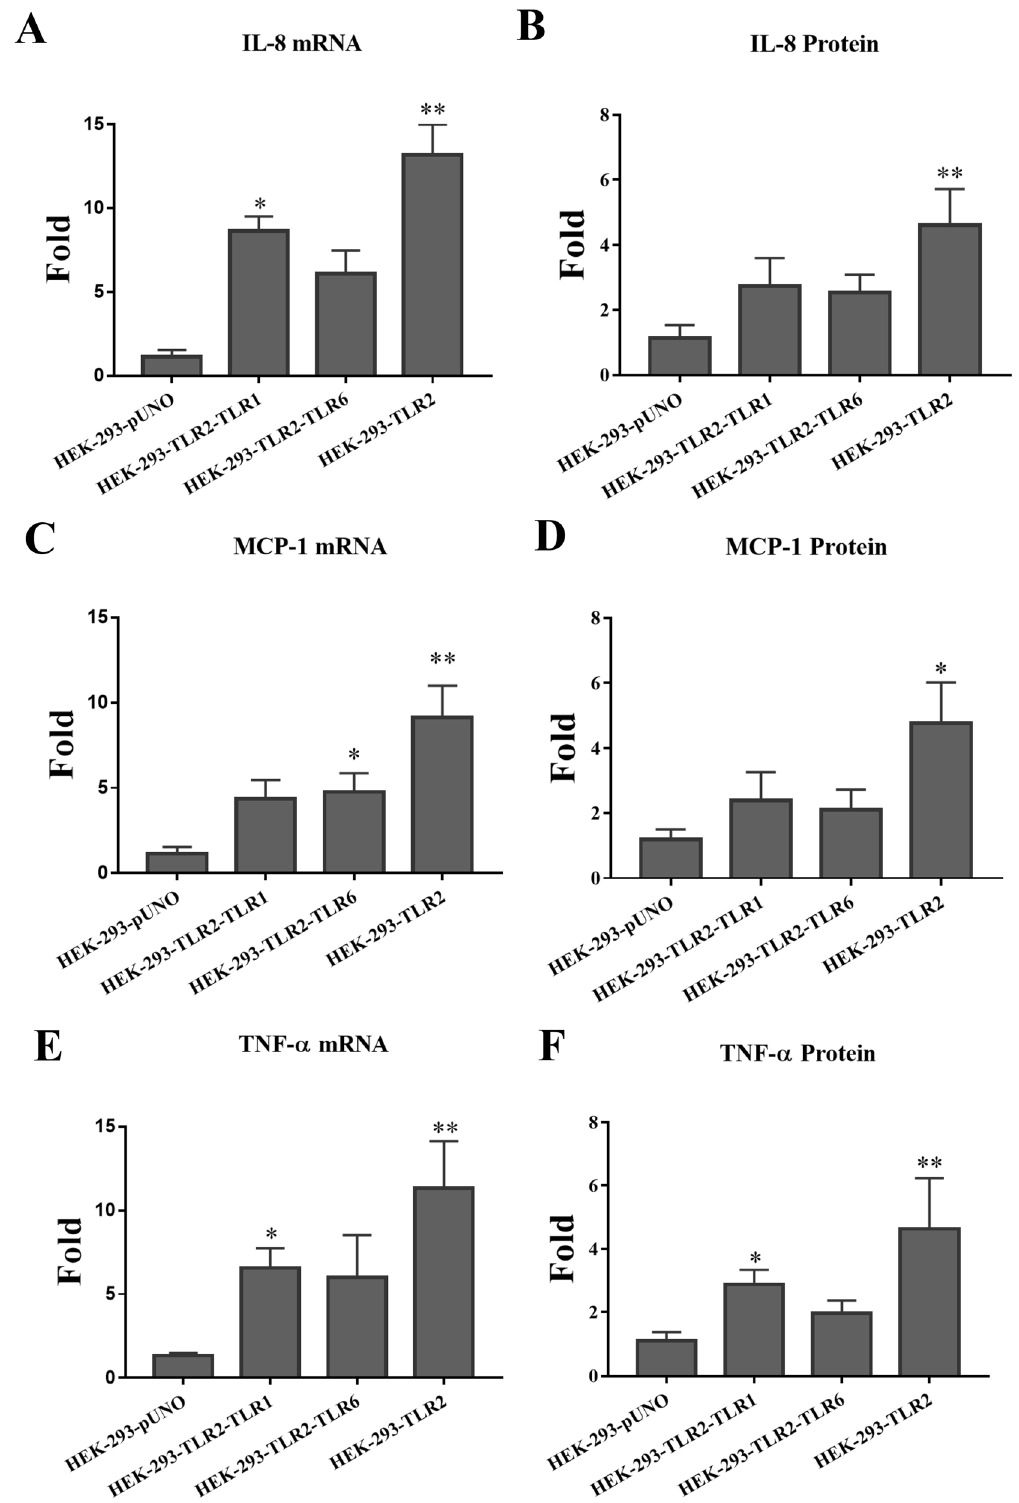
Figure 7. Inflammatory responses induced by rLoa22-LPGN in transient transfection HEK293 cells. Several plasmids (TLR2-TLR1, TLR2-TLR1, and TLR2 only) were transiently transfected into HEK-293 cell and the inflammatory responses induced by rLoa22-LPGN complex were assayed including hCXCL8/IL8, hCCL2/ MCP-1, and hTNF-α. ( A ) Stimulation of the expression of CXCL8/IL8 mRNA. ( B ) Stimulation of the expression of CXCL8/IL8 protein. ( C ) Stimulation of the expression of hCCL2/MCP-1 mRNA. ( D ) Stimulation of the expression of hCCL2/MCP-1 protein. ( E ) Stimulation of the expression of hTNF-α mRNA. (F) Stimulation of the expression of hTNF-α protein. HEK-293-pUNO was used as mock control. ⃰ p < 0.05; ⃰ ⃰ p <